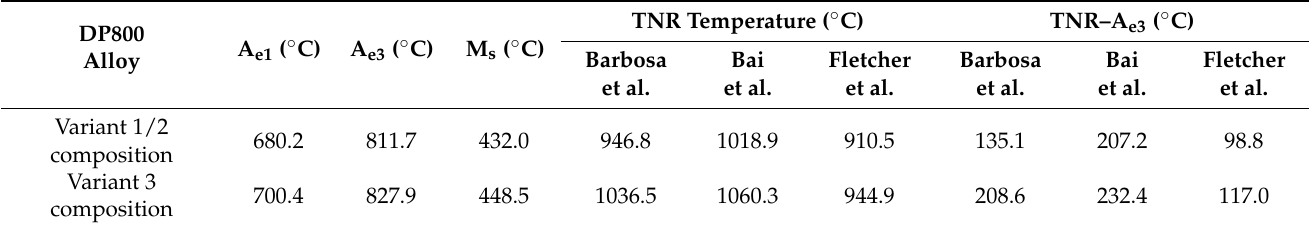
Table 4. Comparison of the Ae1, Ae3, Ms and TNR temperatures for the variant 1/2 composition and Variant 3 composition.